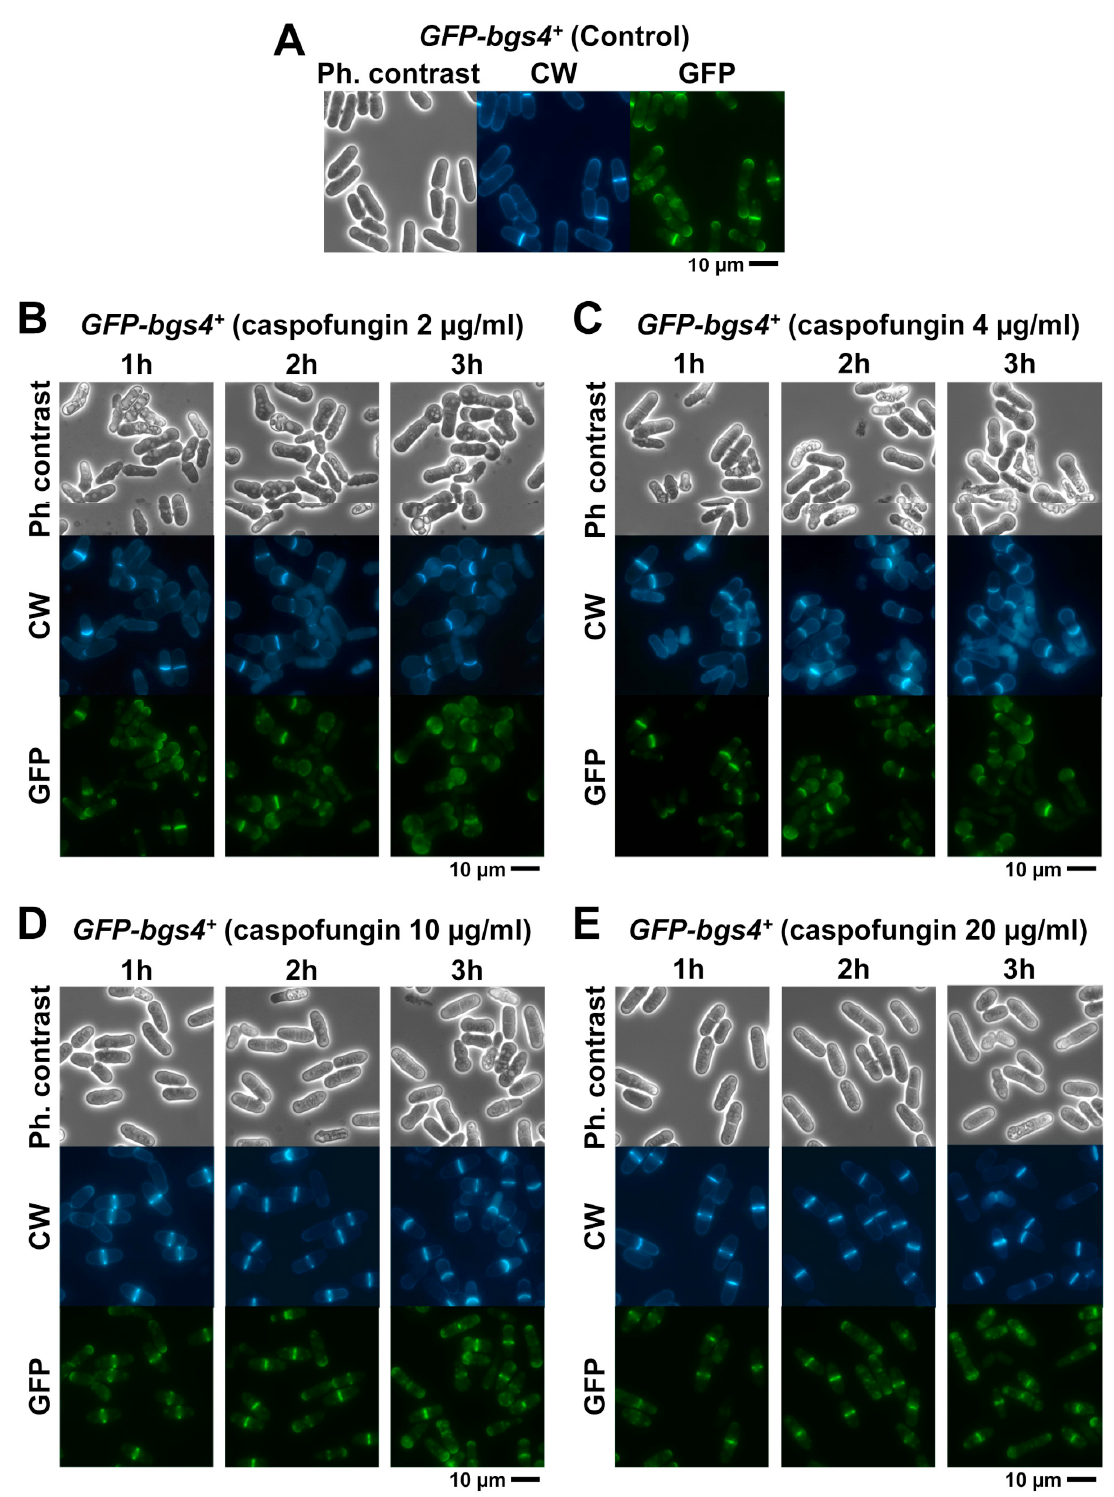
Figure 3. Cell morphology and GFP-Bgs4 localization in cells growing in the presence of sublethal and lethal concentrations of caspofungin. Phase-contrast and fluorescence micrographs of CW- stained GFP-bgs4 + cells. Cells were grown as in Figure 2 and imaged at the indicated times using phase-contrast and CW and GFP fluorescence microscopy either in the absence (( A ): control) or in the presence of sublethal (( B ): 2 µ g/mL; ( C ): 4 µ g/mL) or lethal (( D ): 10 µ g/mL; ( E ): 20 µ g/mL) doses of the antifungal. Scale bars: 10 µ